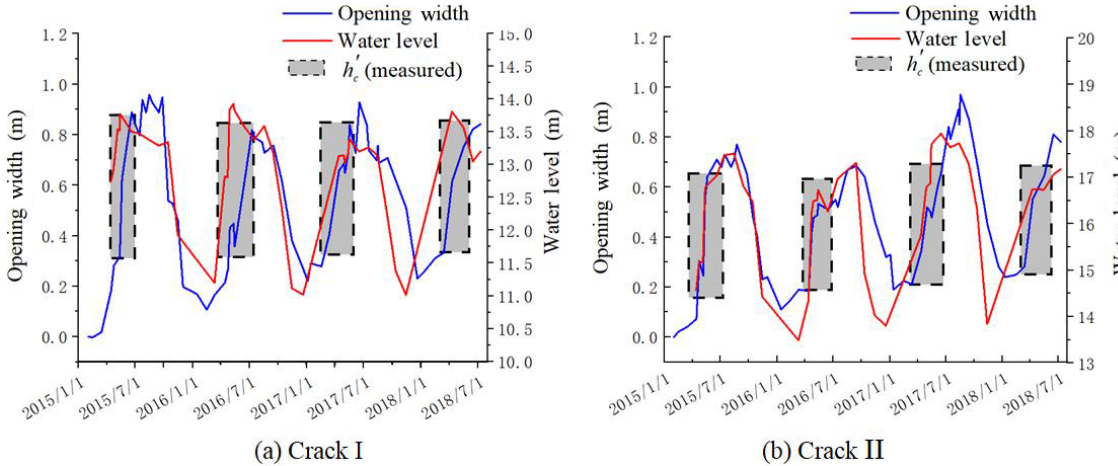
Figure 9. Determination of the measured critical water level h (cid:48) cr .